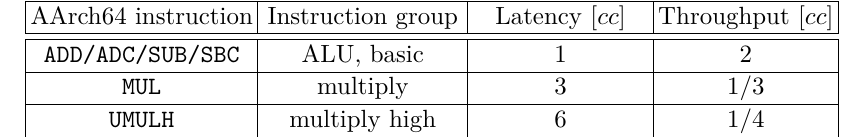
Table 3: Performance comparison of various instructions on the ARM Cortex-A72 processor (64-bit ARMv8-A architecture). Timings are in clock